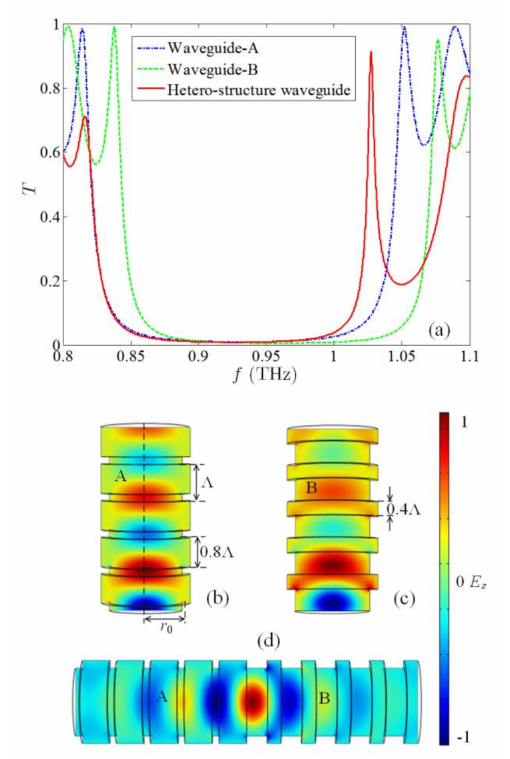
Figure 1. Transmission spectrum and electric field E z components of Waveguides A, B, and the hetero-structure of their combination. ( a ) The blue dash–dot, green dash, and red solid lines are the transmission spectra of Waveguides A and B and the hetero-structure, respectively. The electric fields E z of Waveguides A ( b ) and B ( c ) and the hetero-structure ( d ) at 1.027 THz illustrate the energy attenuation and localization at the interface of the structure. The electric fields were normalized by their own maximum in each